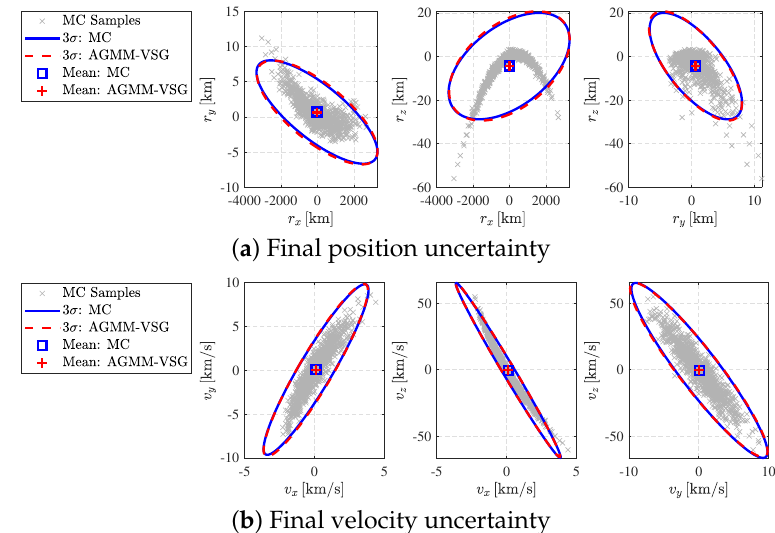
Figure 9. Final uncertainty using AGMM-VSG and MC for TQO case.